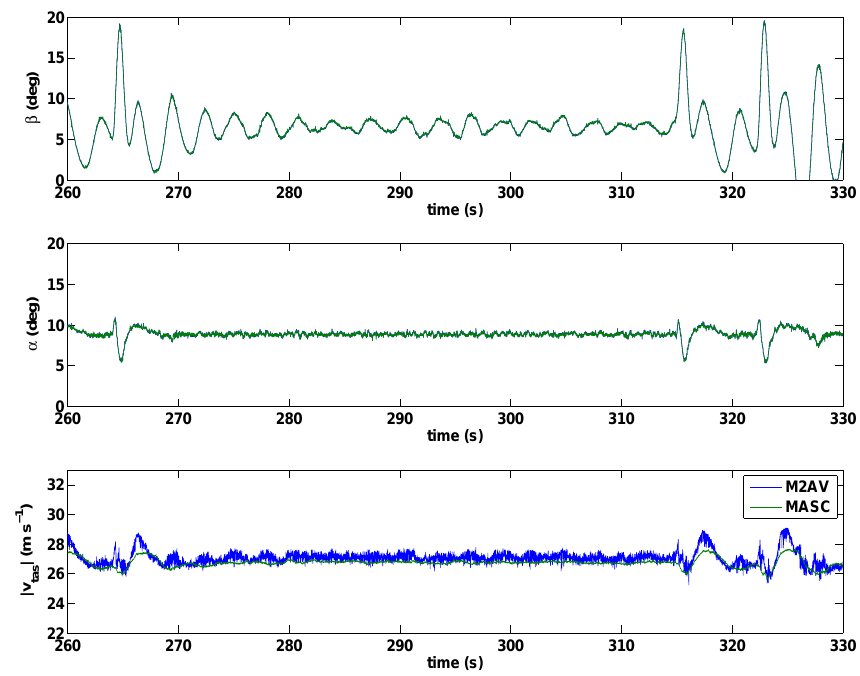
Fig. 10. True airspeed, measured with the five-hole probe and calculated with the M 2 AV and MASC methods respectively. Angle of attack throughout the leg approximately 10 ◦ ; angle of sideslip approximately 8 ◦ . See text for flight conditions.